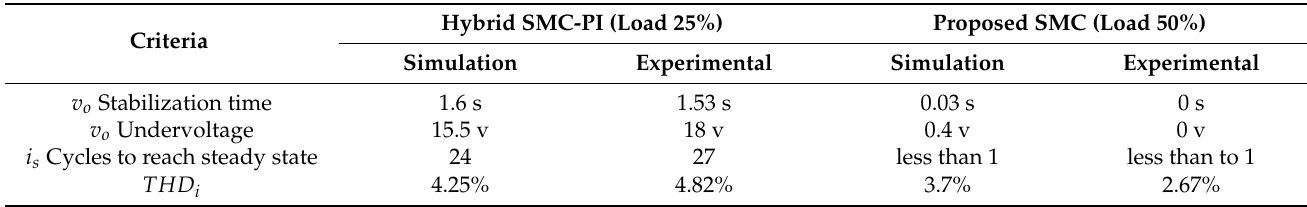
Table 3. Experimental vs. simulation: test with load